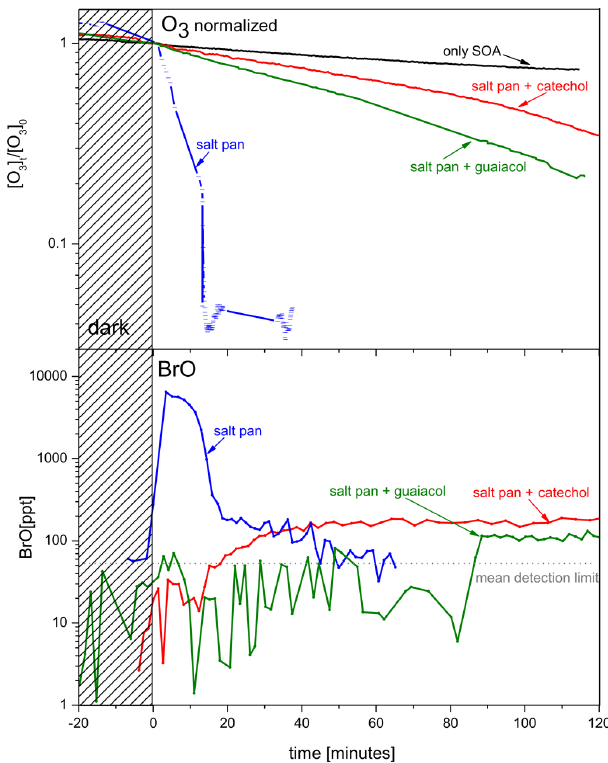
Fig. 12. Time series of ozone (top) and BrO (bottom) show the influ- ence of SOA from catechol and guaiacol on the release of RHS from the simulated salt pan. Ozone values are normalized to the O 3 mix- ing ratios at t = 0. The experiments were carried out at 60%RH. During an experiment, where only the salt pan without SOA pre- cursor was exposed to simulated sunlight (blue lines, from Bux- mann et al., 2012), ozone was destroyed within less than 20min and more than 6000pptBrO were formed. Measurements of O 3 were performed only for limited periods of time (indicated by horizontal bars), to reduce dilution. During experiments with SOA precursors (indicated in red, green and black) ozone decay was much slower. BrO exceeds the mean detection limit of 57ppt with a time delay (after the solar simulator was switched on at t = 0) of 18min for catechol and 87min for guaiacol. Maximum BrO mixing ratios of less than 200ppt were observed, one order of magnitude lower than without